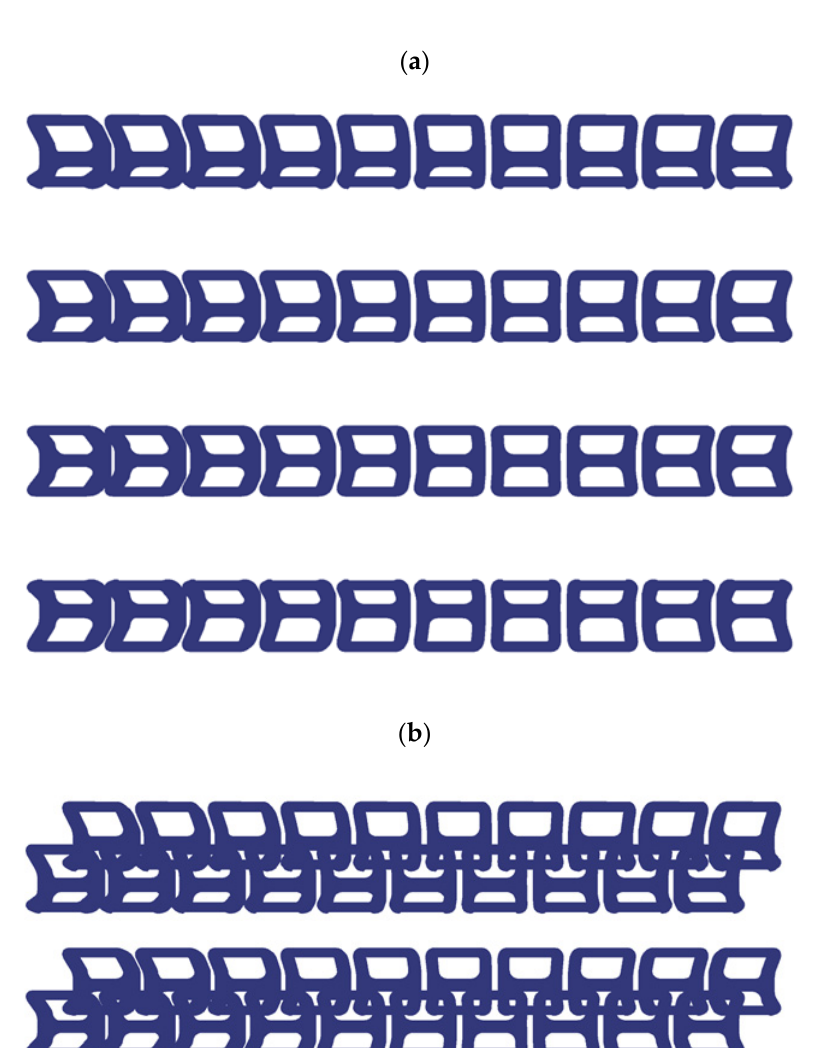
Figure 5. Construction of the chainmail from single elements: ( a ) single element, ( b ) single elements as the chainmail.